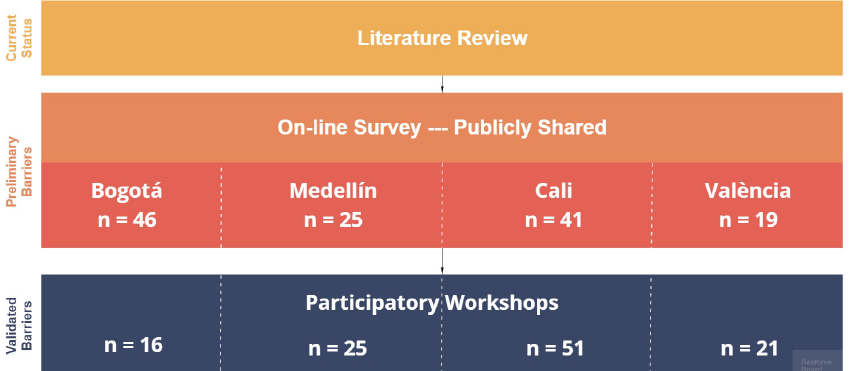
Figure 1. Workflow used. Literature review, identifying initial barriers and perceptions, then a publicly shared online survey ( n = 195 valid responses). Using the preliminary results, four cities were selected and the identified barriers were contrasted with the participatory workshop in each